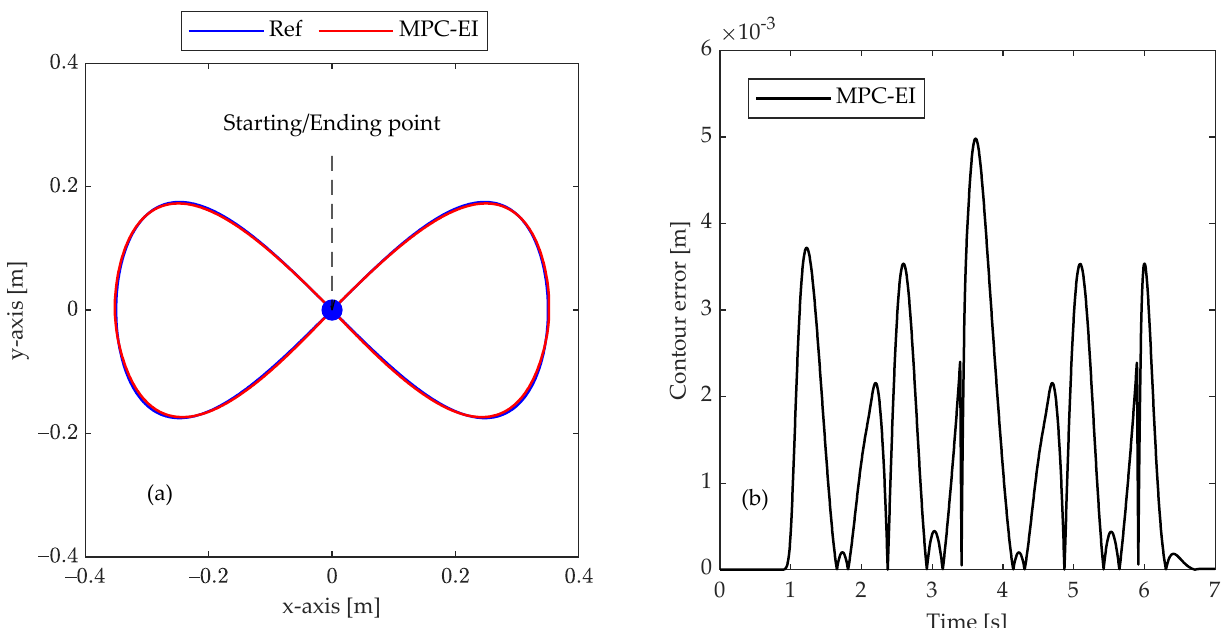
Figure 8. Path tracking response of the Gerono’s lemniscate: spatial representation ( a ) and its contour error ( b ).